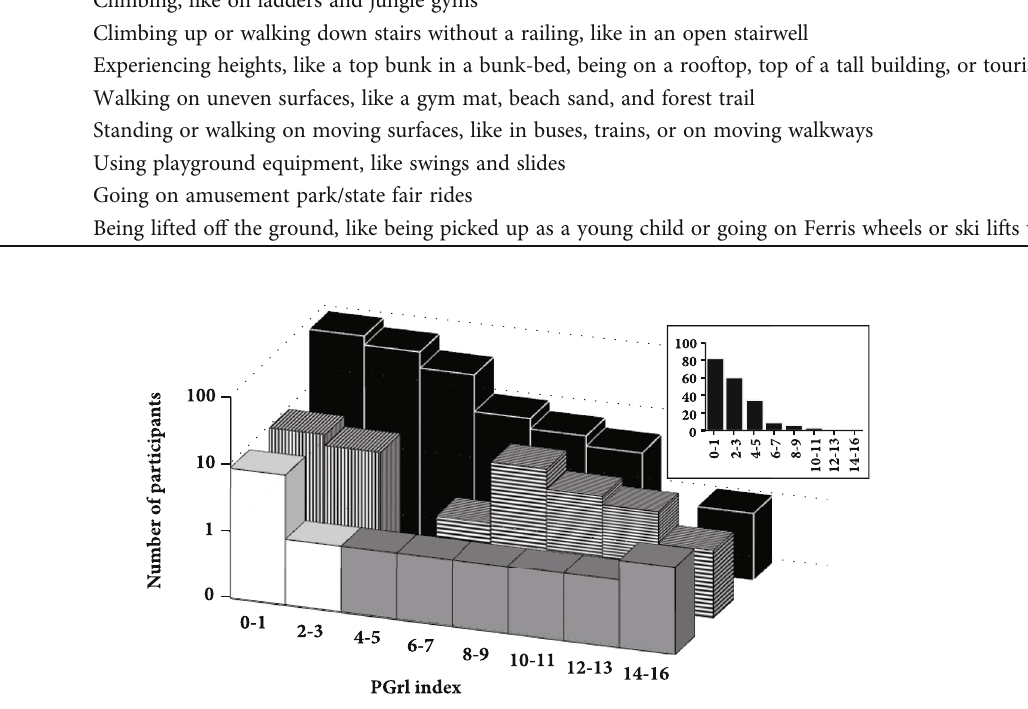
Figure 1: Population, study, and clinic sample PGrI scores plotted on a modi fi ed log scale. Back row population sample (black, N = 202 ): 70% have scores ≤ 3 and 9% have scores ≥ 7. Upper right inset: linear y -axis number scale shows true left skew of population scores. Front row clinic sample: OT clinic individuals without GrI (white) and OT clinic individuals with GrI (gray). Middle row: study comparison group (vertical stripes) is from 70% of population without balance problems. Balance-challenged MGrI scores (horizontal stripes) are within range of OT clients with GrI. Table 2: Demographics of the mild GrI and comparison groups; results of walking caution question and ANCOVAs of shear force oscillation